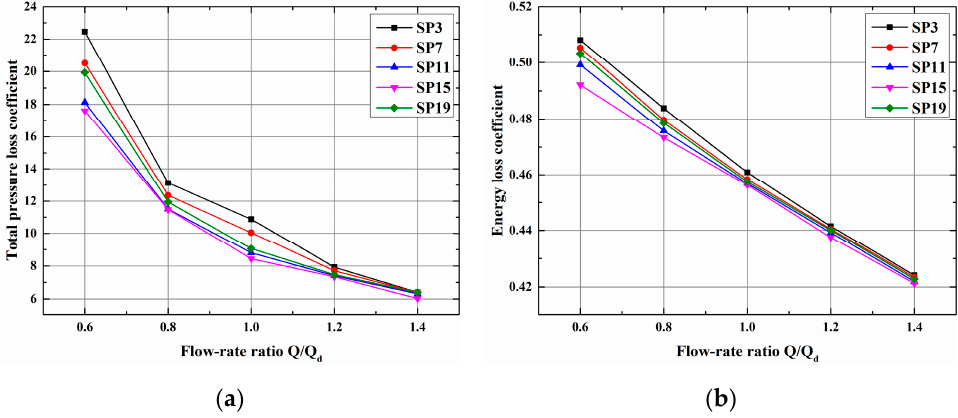
Figure 14. Variation in the pressure and the energy loss coefficient with respect to mass flow rate (Ls = 80%): ( a ) Curve of total pressure loss coefficient; ( b ) curve of energy loss coefficient.